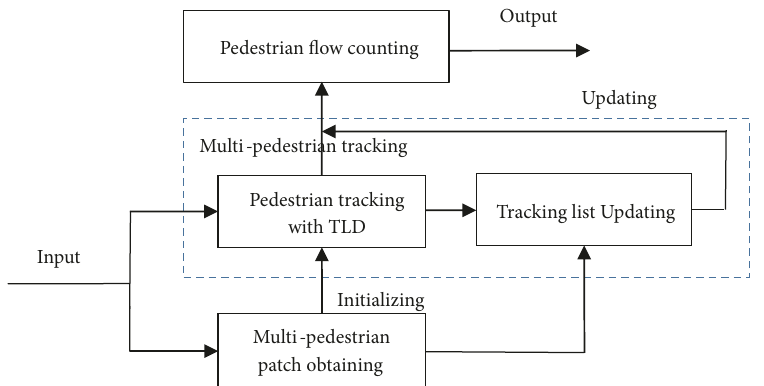
Figure 1: The framework of our proposed